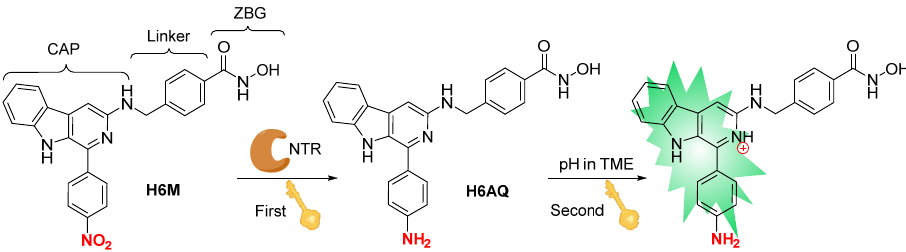
Figure 1. Design of “double-locked” and enzyme/pH-activated theranostic agent H6M .